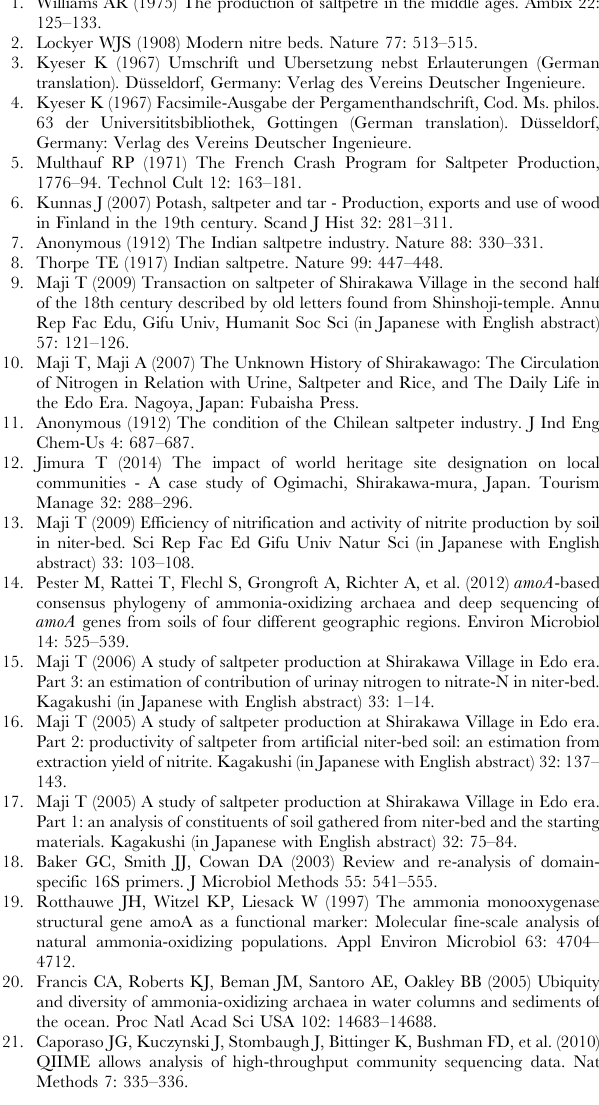
Table S5 The relative abundances of ammonia-oxidiz- ing bacteria and archaea in 16S rRNA gene pyrotag libraries. Table S6 Phylogenetic identification of OTUs derived from bacterial and archaeal amoA gene sequences.